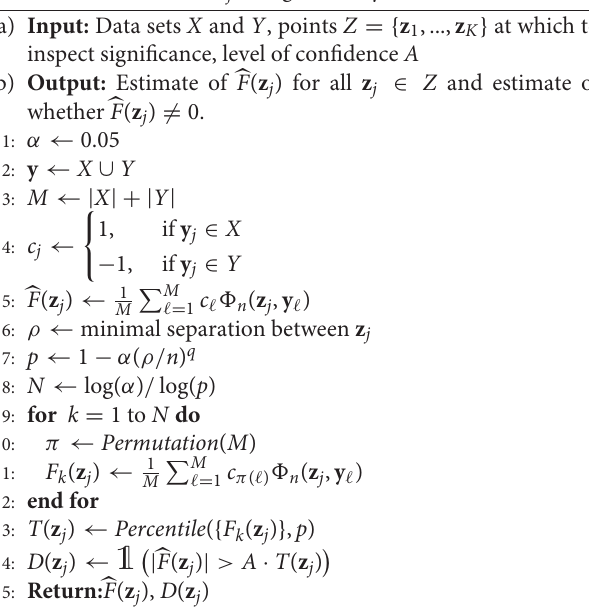
Algorithm 1: Algorithm for determining significance